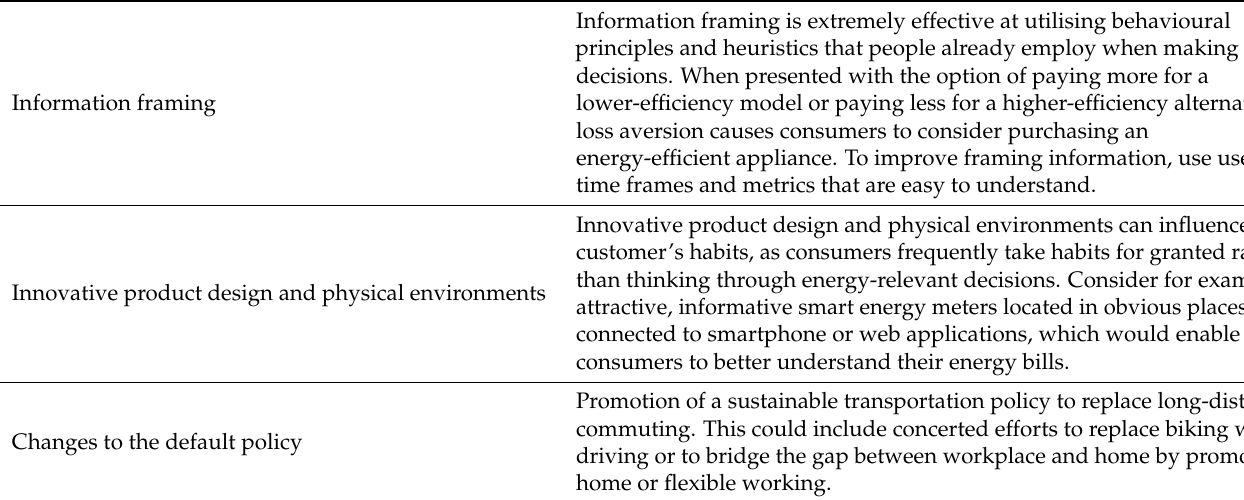
Table 1. Time-use behaviour intervention